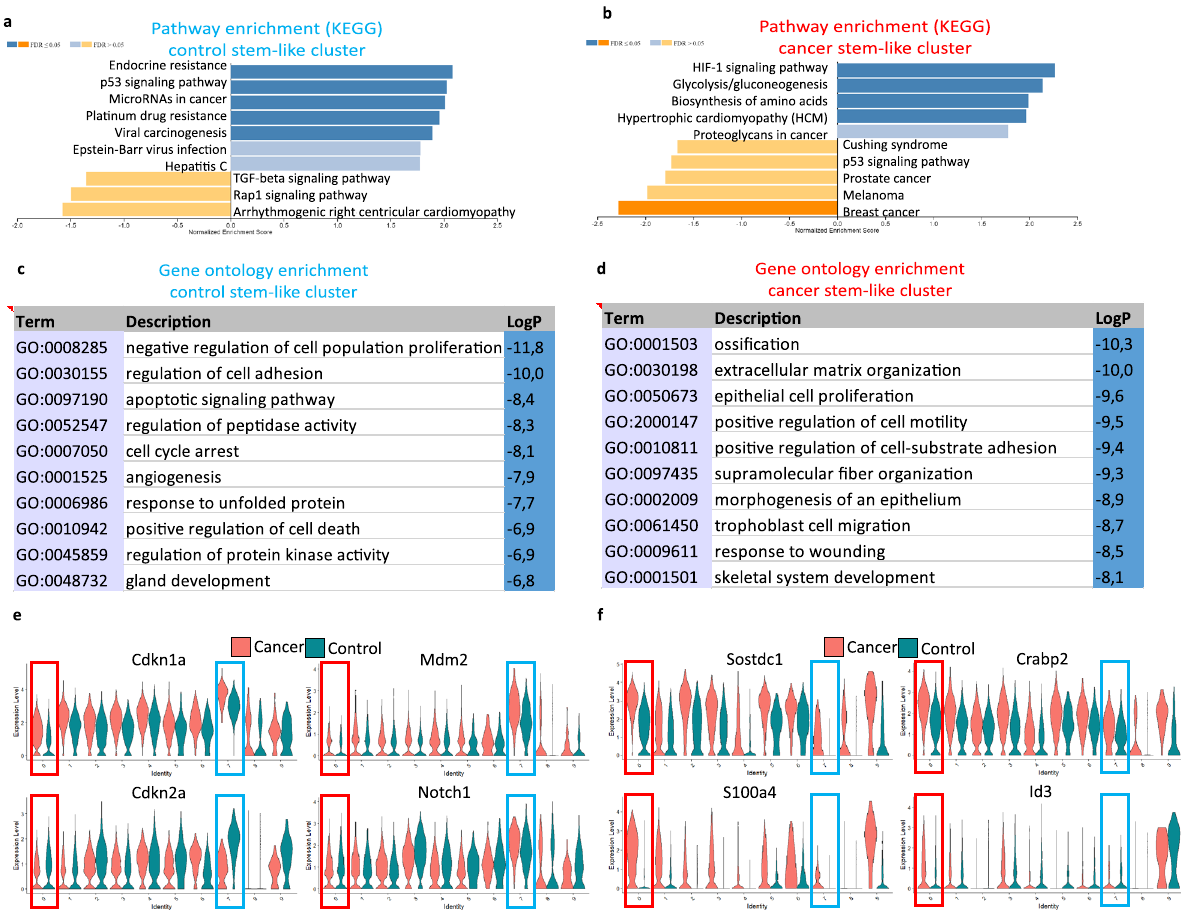
Figure 5. Kyoto Encyclopedia of Genes and Genomes (KEGG) pathway enrichment, Gene Ontology (GO) enrichment, and gene expression analyses in control and cancer stem-like cell clusters of the integrated object. ( a ) Bar graph showing upregulated (blue) and downregulated (yellow/orange) KEGG pathways in the control stem-like cell cluster (cluster 7) compared to the cancer stem-like cell cluster (cluster 0). ( b ) Bar graph showing upregulated (blue) and downregulated (yellow/orange) KEGG pathways in the cancer stem-like cell cluster (cluster 0) compared to the control stem-like cell cluster (cluster 7). Dark blue and orange bars in ( a ) and ( b ) indicate false discovery rate (FDR) ≤ 0.05, while light blue and yellow bars indicate FDR > 0.05. ( c ) Top 10 enriched GO biological process terms in the control stem-like cell cluster. ( d ) Top 10 enriched GO biological process terms in the cancer stem-like cell cluster. ( e ) Violin plots of selected genes upregulated in the control stem-like cell cluster. ( f ) Violin plots of selected genes upregulated in the cancer stem-like cell cluster. Red (cancer) and blue (control) rectangles highlight the stem-like clusters in ( e ) and ( f ). KEGG is developed by Kanehisa Laboratories (http:// www. kegg. jp/ kegg/ kegg1.